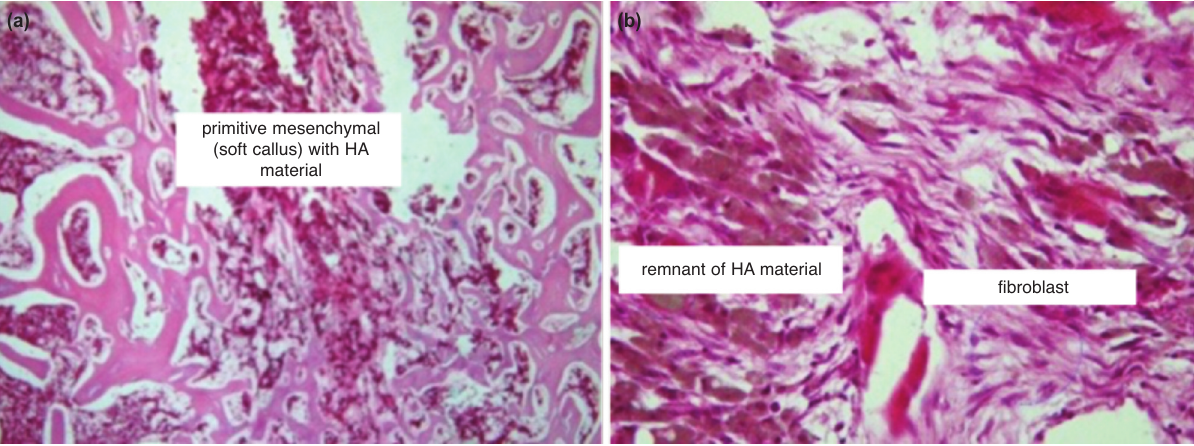
Histology features of Group O3 (HA:PMMA ratio 3:1); (a) The space gap was partially filled with callus formation (5X, HE). Fig. 4: (b) A prominent remnant of HA material in fibrous callus formation (20X,